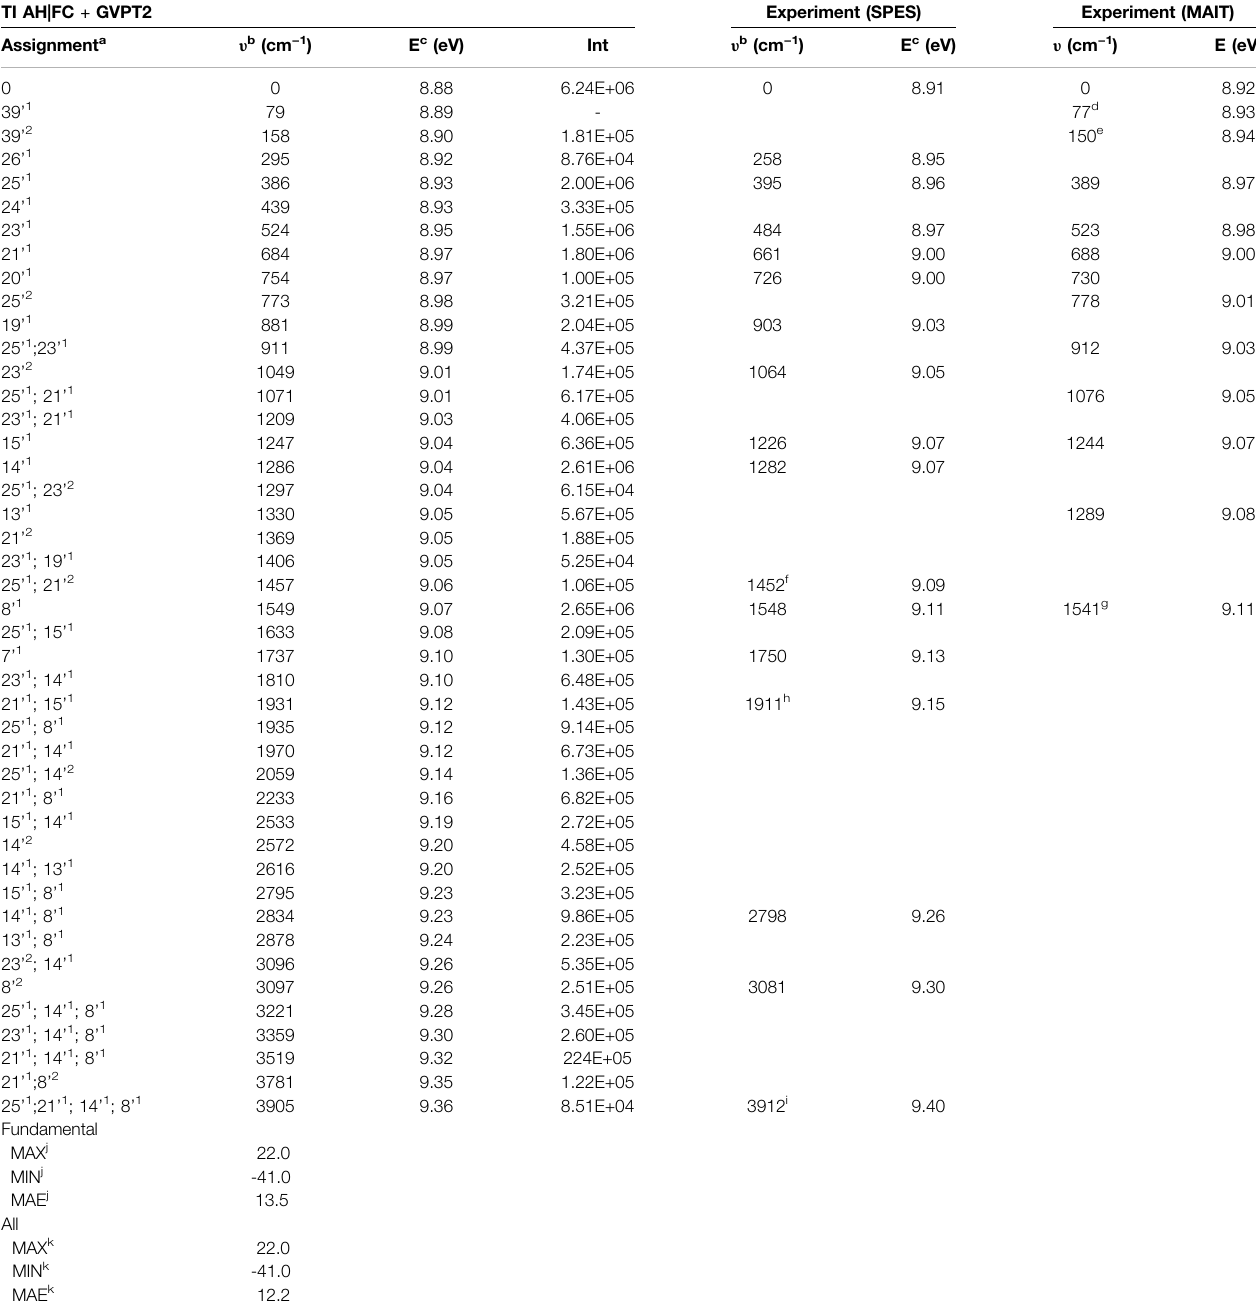
TABLE 3 | TI AH|FC photoelectron spectra, selected transitions compared to the SPES and VUV-MATI experimental spectra. TI AH|FC + GVPT2 Experiment (SPES) Experiment (MAIT) Assignment